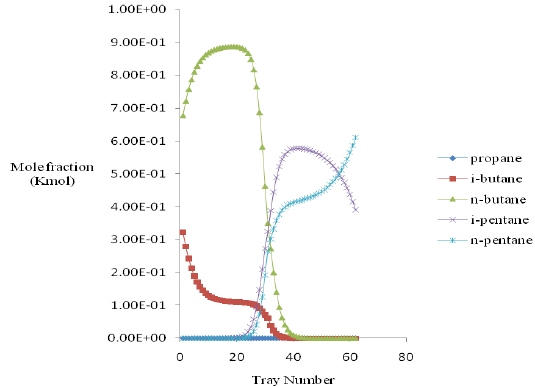
Figure 4. Molar Composition of Debutanizer of the Base